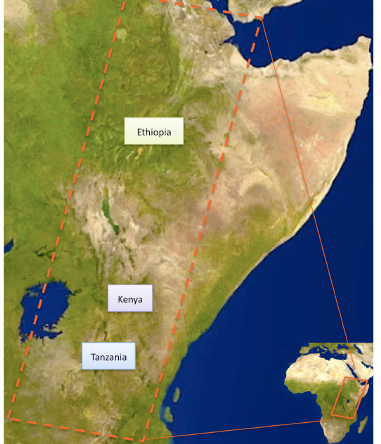
Figure 1. Localization of the three study areas.